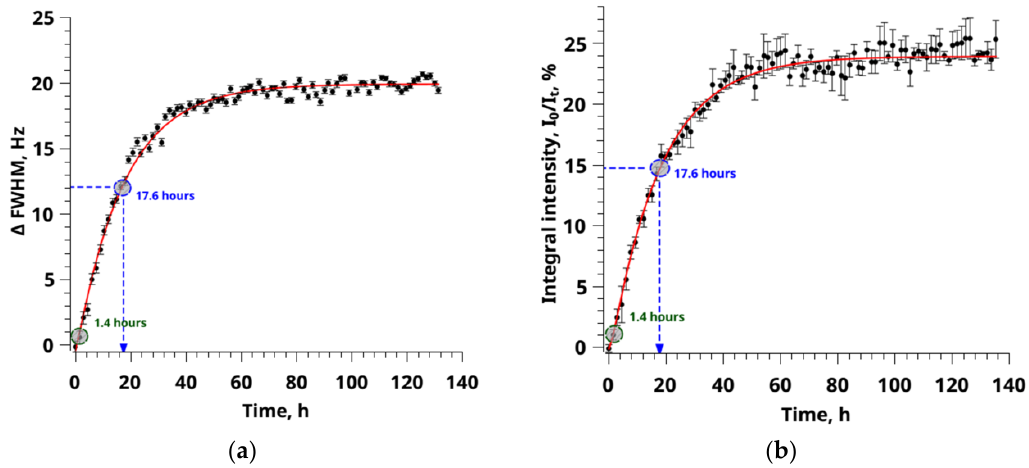
Figure 7. ( a ) A graph of the change dependence in the signal width parameter at the half-height of the 13 C CO 2 signal on time, approximated by a two-exponential model. Where ∆ FWHM = FWHM 0 - FWHM t , where FWHM 0 and FWHM t are the half-widths of the signals at half-height at the initial time and observation time t, respectively. ( b ) A graph of the change dependence in the parameter of the integral intensity of the 13 C CO 2 signal on time, approximated by a two-exponential model. Where I 0 and I t are the values of the integral signal intensity at the initial moment of time and the observation time t. The blue and green circles on the graphs show the values of the correlation times of the sorption and swelling processes, respectively.